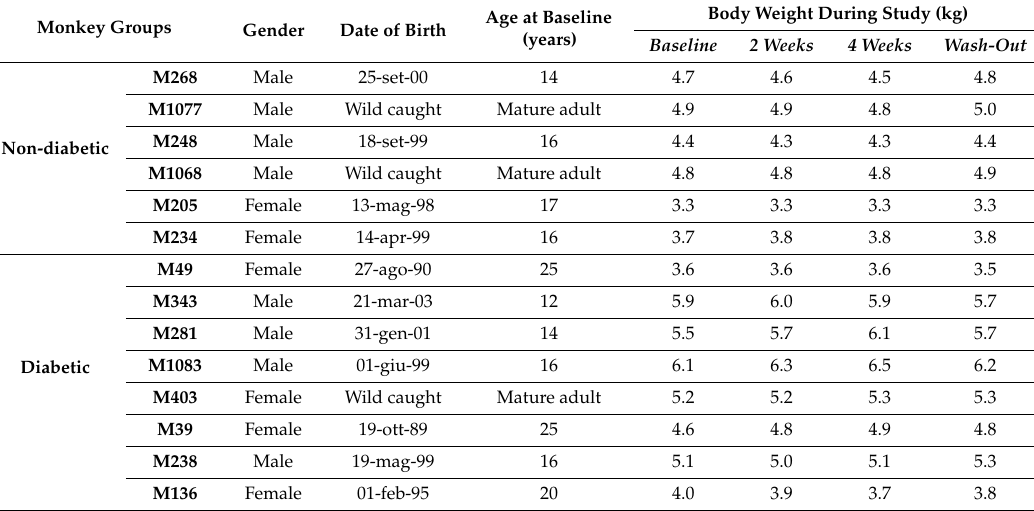
Table 1. Demographic data of vervet